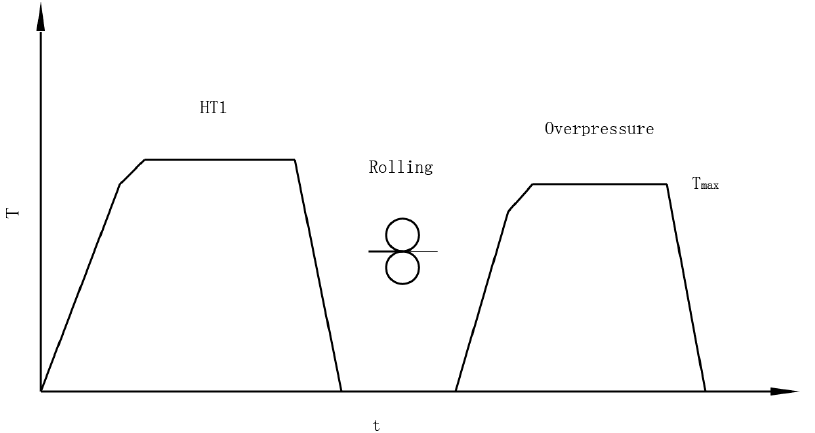
Figure 3. Heat treatment schedule for Bi-2223 wires. The Bi-2223 wires are rolled after the first heat treatment and then treated using the overpressure method.